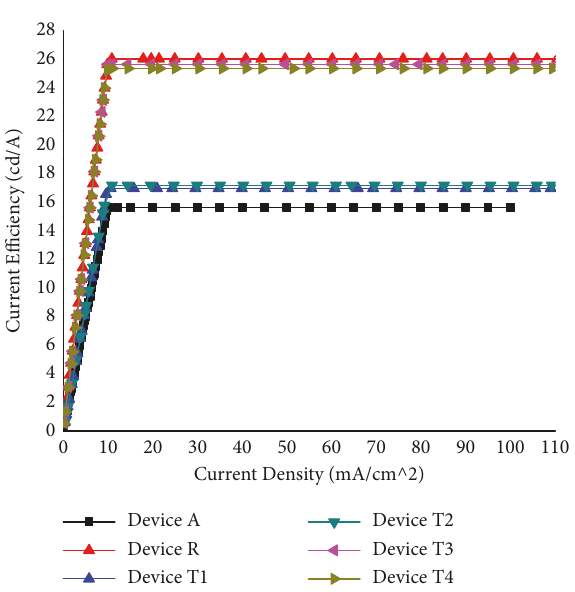
Figure 7: Current efficiency plot of various devices.